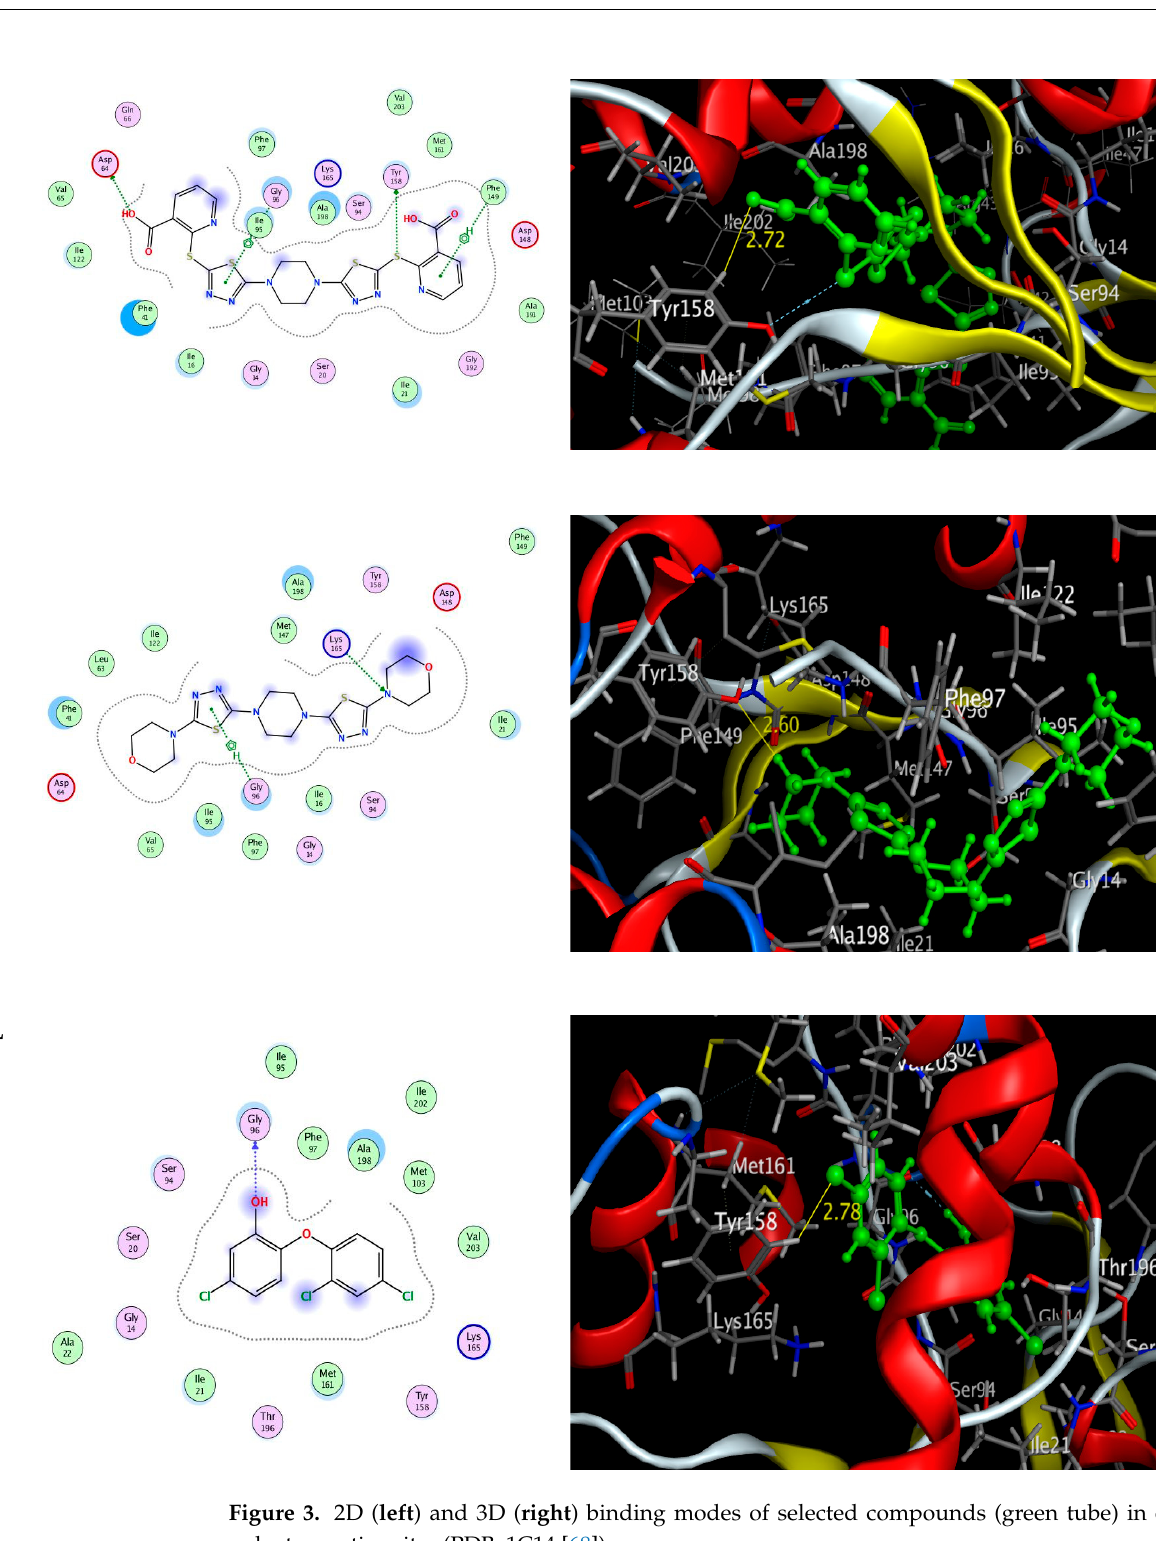
Figure 3. 2D ( left ) and 3D ( right ) binding modes of selected compounds (green tube) in enoyl Figure 3. 2D (left) and 3D (right) binding modes of selected compounds (green tube) in enoyl reductase active sites (PDB: reductase active sites (PDB: 1C14 1C14 [68]). Table 3. Docking results of 2–10 docked into enoyl reductase.